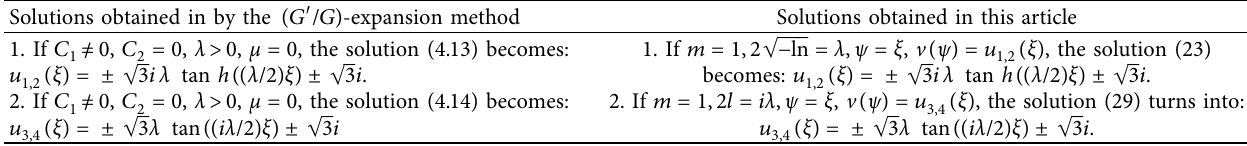
Table 1: Comparison of the results of the modifed Zakharov–Kuznetsov (mZK) model. Solutions obtained in by the ( G ′ / G ) -expansion method Solutions obtained in this